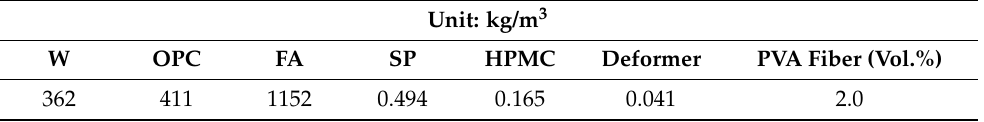
Table 2. Mixture proportion of ECC.